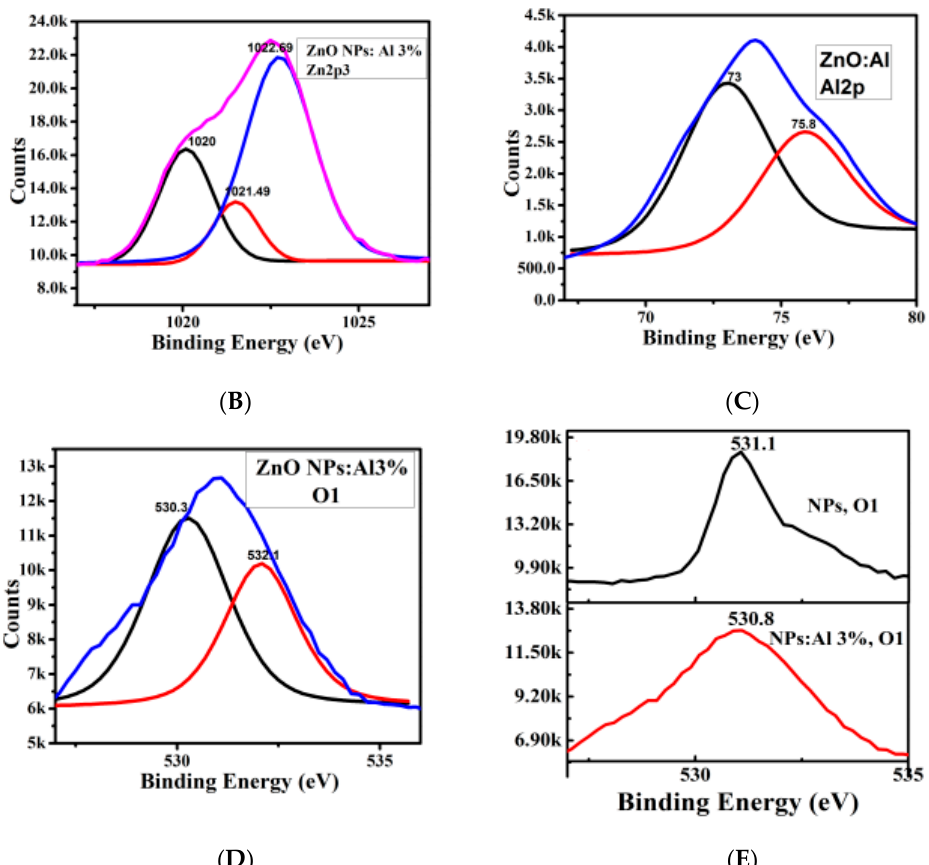
Figure 7. X-ray photoelectron spectroscopy of pure and 3 mol % Al doped ZnO NSs. ( A ) survey scan of the doped sample, the narrow scan of Zn2p 3 / 2 in the doped sample ( B ), narrow scan of Al2p in the doped sample ( C ), and O1s in the doped sample ( D ). The peak positions of O1s in both pure and Al doped ZnO NSs is shown in ( E ).